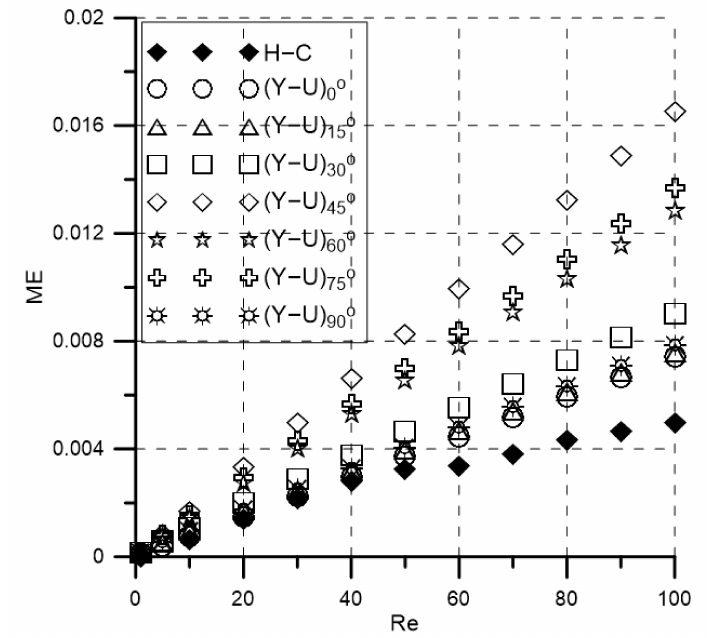
Figure 12. Mixing effectiveness of the micromixers at various Reynolds